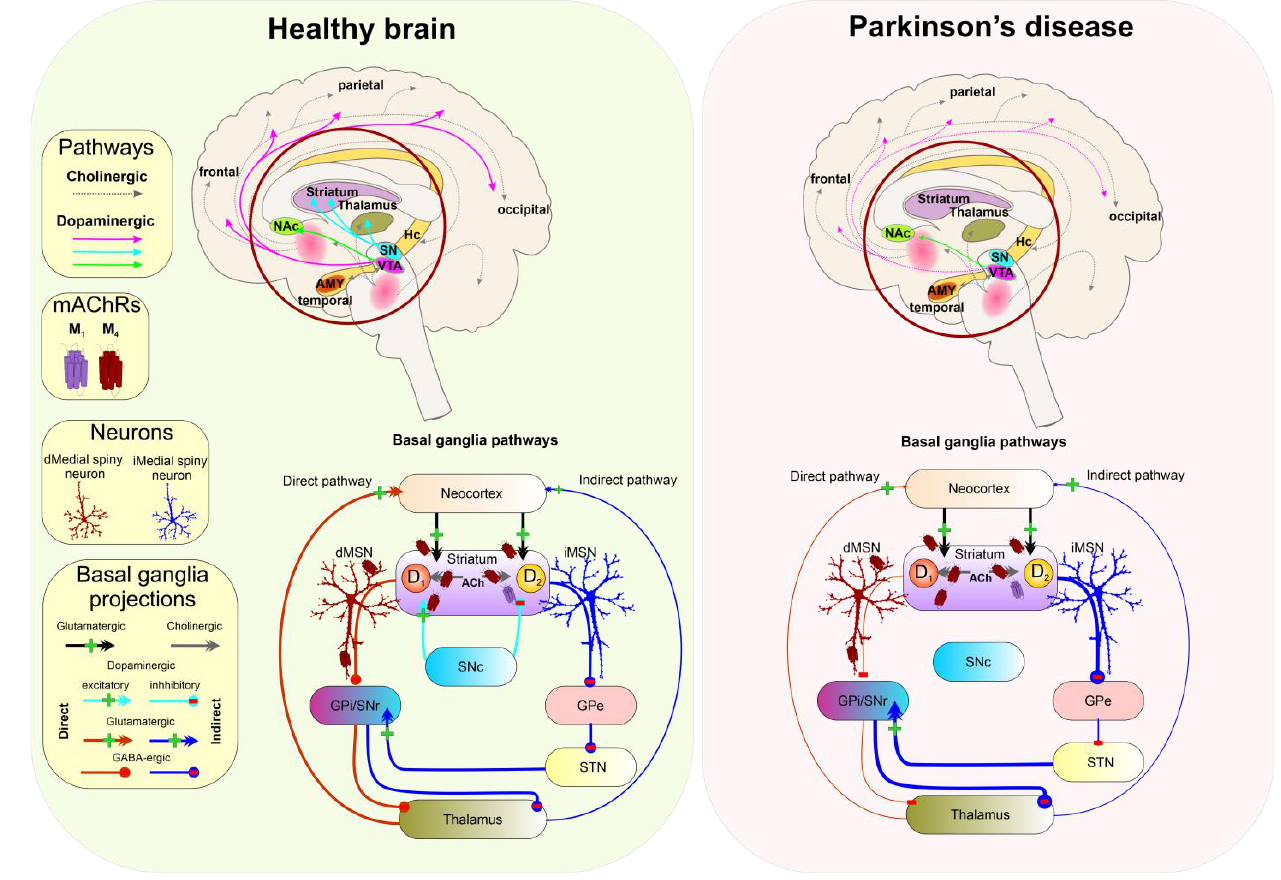
Figure 5. Neural pathways and circuits implicated in Parkinson’s disease. Left: In the healthy brain, the diagonal band of Broca (BG) nuclei provides control over the movements by the direct or indirect inhibition of the excitatory activity of the thalamus by the globus pallidus (GP). The net effect of activation of the direct pathway is a fine-tuned stimulation of the motor cortex, allowing for voluntary motor activity. Excitatory projections from the neocortical cholinergic interneurons (grey arrows) into the striatum and release of dopamine from the substantia nigra pars compacta (SNc) (cyan) activate striatal D 1 (excitatory) receptors, which in turn activate inhibitory medial spiny neurons of direct pathway (dMSNs) (dark red). The dMSNs send their projections (red line) to the GPi/SNr and reduce their strong inhibitory tone. Though GPi/SNr send their inhibitory projections (red line) to the thalamus, the GP/SNr inhibitory tone is diminished, allowing for adjusted stimulation of the motor cortex (light red arrow) and controlled movement. The indirect pathway acts along with the direct pathway to prevent overstimulation of the thalamus and thus excessive or involuntary movements. In the indirect pathway, excitatory inputs from the cortex that synapse on cholinergic interneurons and dopamine release from the SNc, stimulate striatal dopaminergic D 2 (inhibitory) receptors. This reduces the inhibitory tone of the iMSN projections (blue) on the GPe. Disinhibited GPe sends fewer inhibitory signals to STN. In turn, activated STN sends excitatory projections (blue arrow) to the GPi/SNr which stimulates it to send more inhibitory signals to the thalamus which sends fewer excitatory inputs to the cortex. Activation of the indirect pathway results in inhibition of the motor activity. Right: In the PD, loss of dopaminergic neurons projecting from the SNc results in diminished activation of the dMSN and disinhibition of iMSN, stimulating indirect pathway, resulting in strong inhibition of GPe. Consequently, strong activation of GPi/SNr and inhibition of the thalamus and cortex occur. In the effect, voluntary motor control is lost. Selective negative modulation of the M 4 receptors on the corticostriatal projections, dMSN, and cholinergic interneurons (red receptor) could reduce parkinsonian motor disability according to